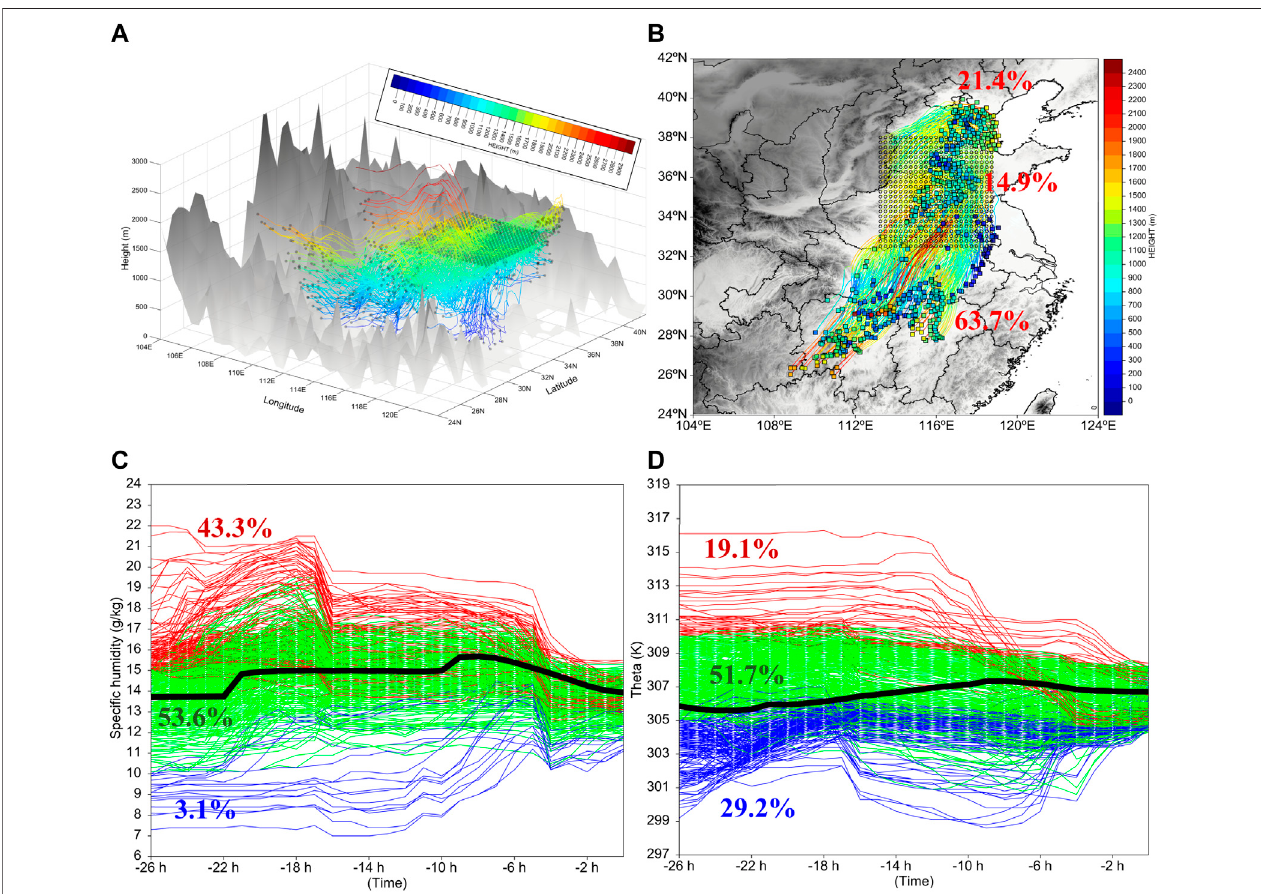
FIGURE 10 | Panel (A) shows the three-dimensional backward trajectories associated with the 529 dots within the main body of the vortex. Panel (B) shows the height variations along the 529 backward trajectories, where the percentage represents the proportion of the air particles sourced from the regions South of, within and North of the vortex ’ s main body. Panel (C) shows the variations of speci fi c humidity along the 529 backward trajectories, where blue means the initial speci fi c humidity was below 10 g kg − 1 , green means the initial value was between 10 and 15 g kg − 1 , and red means the initial value was above 15 g kg − 1 , with corresponding coloredvaluesshowingitscontribution.Thethickblacklineshowsthemeanofall529trajectories.Panel (D) showsthevariationsofpotentialtemperaturealongthe529 backward trajectories, where blue means the initial potential temperature was below 305 K, green means the initial value was between 305 and 310 K, and red means the initial value was above 310 K, with corresponding colored values showing its contribution. The thick black line shows the mean of all 529 trajectories.